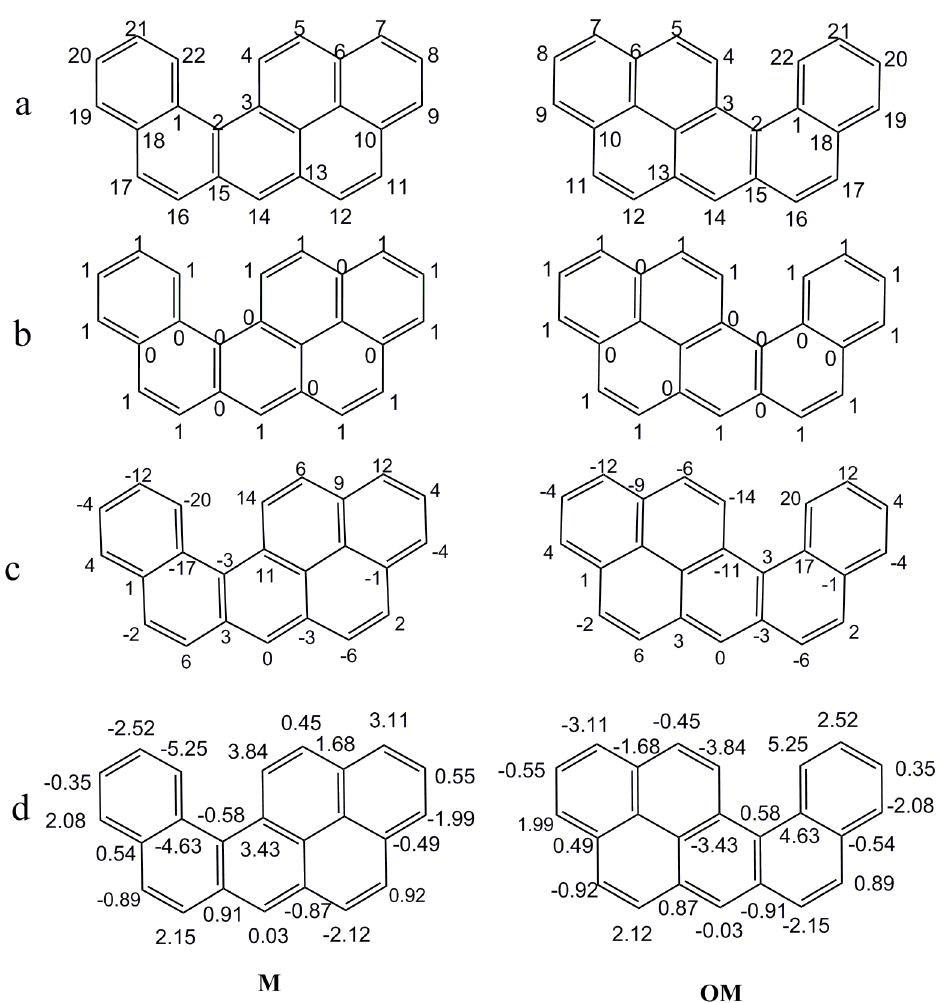
Figure 1. Atomic asymmetry of a pair of enantiomers M and OM. a) atom numbers; b) binary codes; c) atomic sums; d) weighted atomic sums.